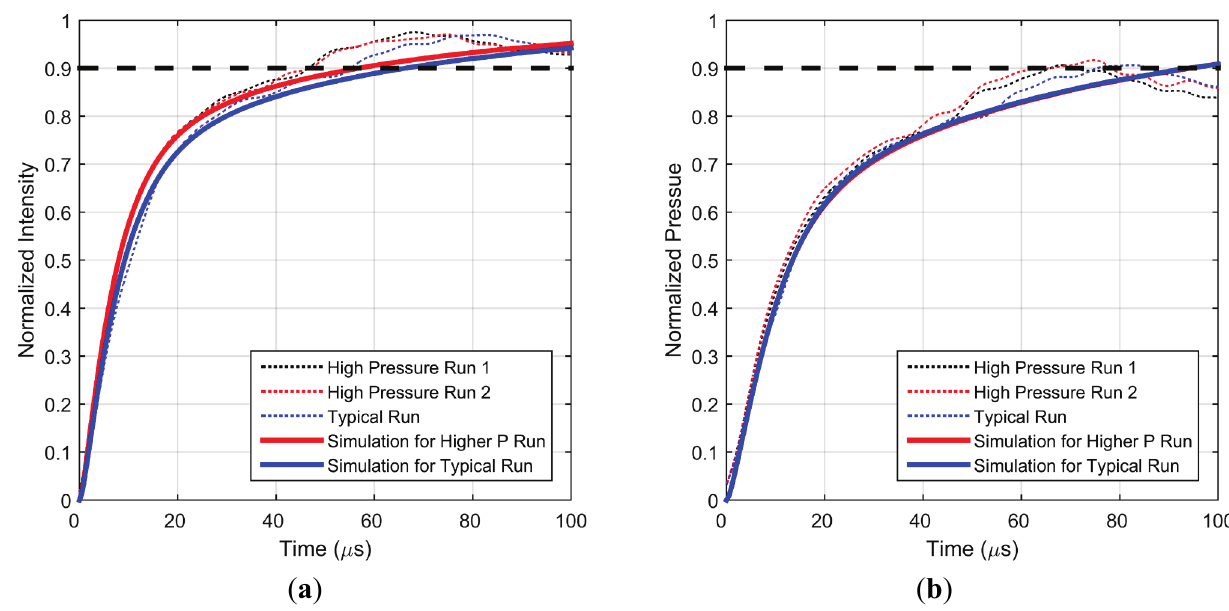
Figure 7. Measured and simulated intensity ( a ) and pressure ( b ) step response for higher final